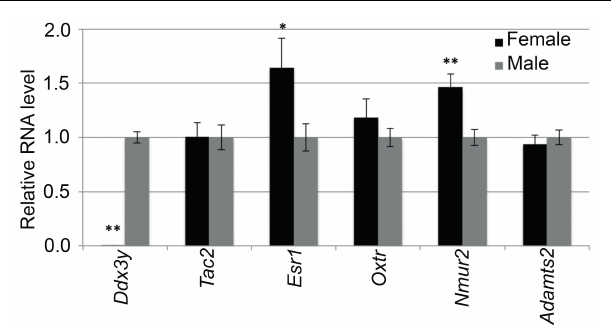
FIGUREA1 | Quantitative RT-PCR analysis of selected transcripts in the hypothalamus. Expression difference is represented as fold-change in females relative to males ( N = 4 females, 4 males). mRNA levels of Ddx3y , Tac2 , Esr1 , Oxtr , Nmur2 , and Adamts2 were normalized to the